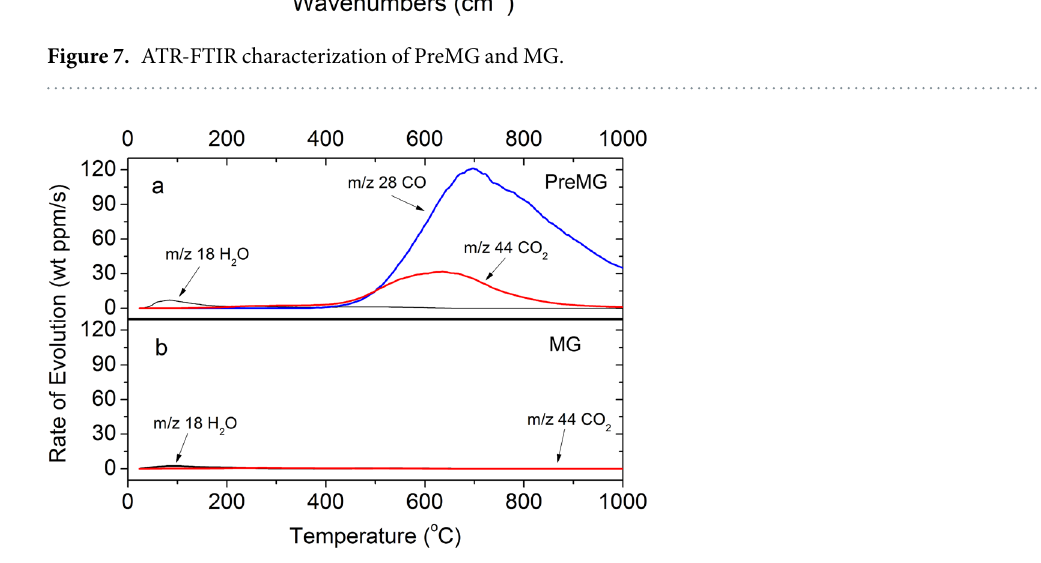
Figure 8. TPD-MS analysis of ( a ) PreMG and ( b )